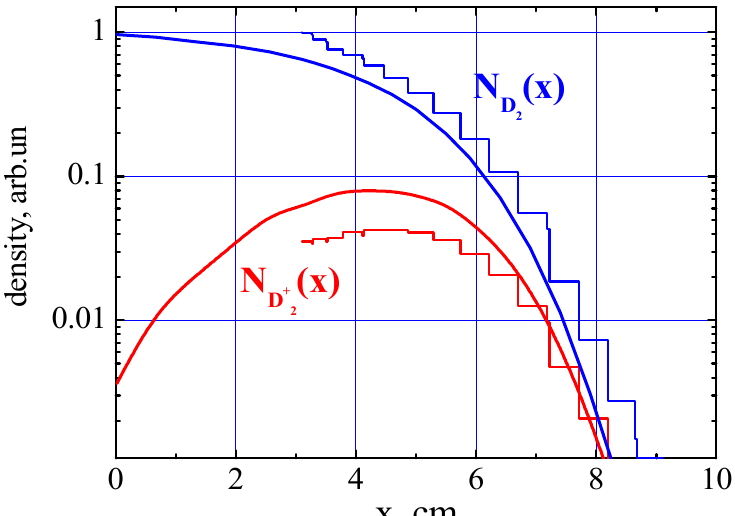
Figure 3. Comparison of space profiles of molecules and molecular ions of deuterium for the outer part of horizontal chord. Solid line—ballistic model, histogram (stepped line)—EIRENE code